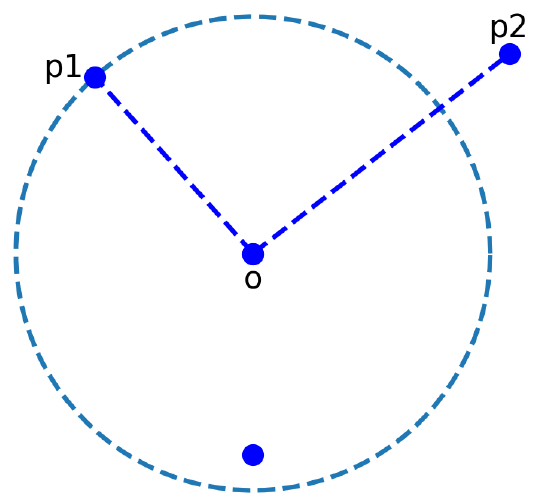
Figure 1. An example scenario for the computation of reachability distance using k = 3. The dotted circle represents the k neighborhood of point o . All blue points represent the data samples. For the demonstration, let us consider only two points, p1 (lies within the k neighborhood) and p2 (lies outside the k neighborhood). The reachability distance between point p1 and o will be the k -distance ( knnsearch , MATLAB [40])) whereas the reachability distance between point p2 and o will be the Euclidean distance between